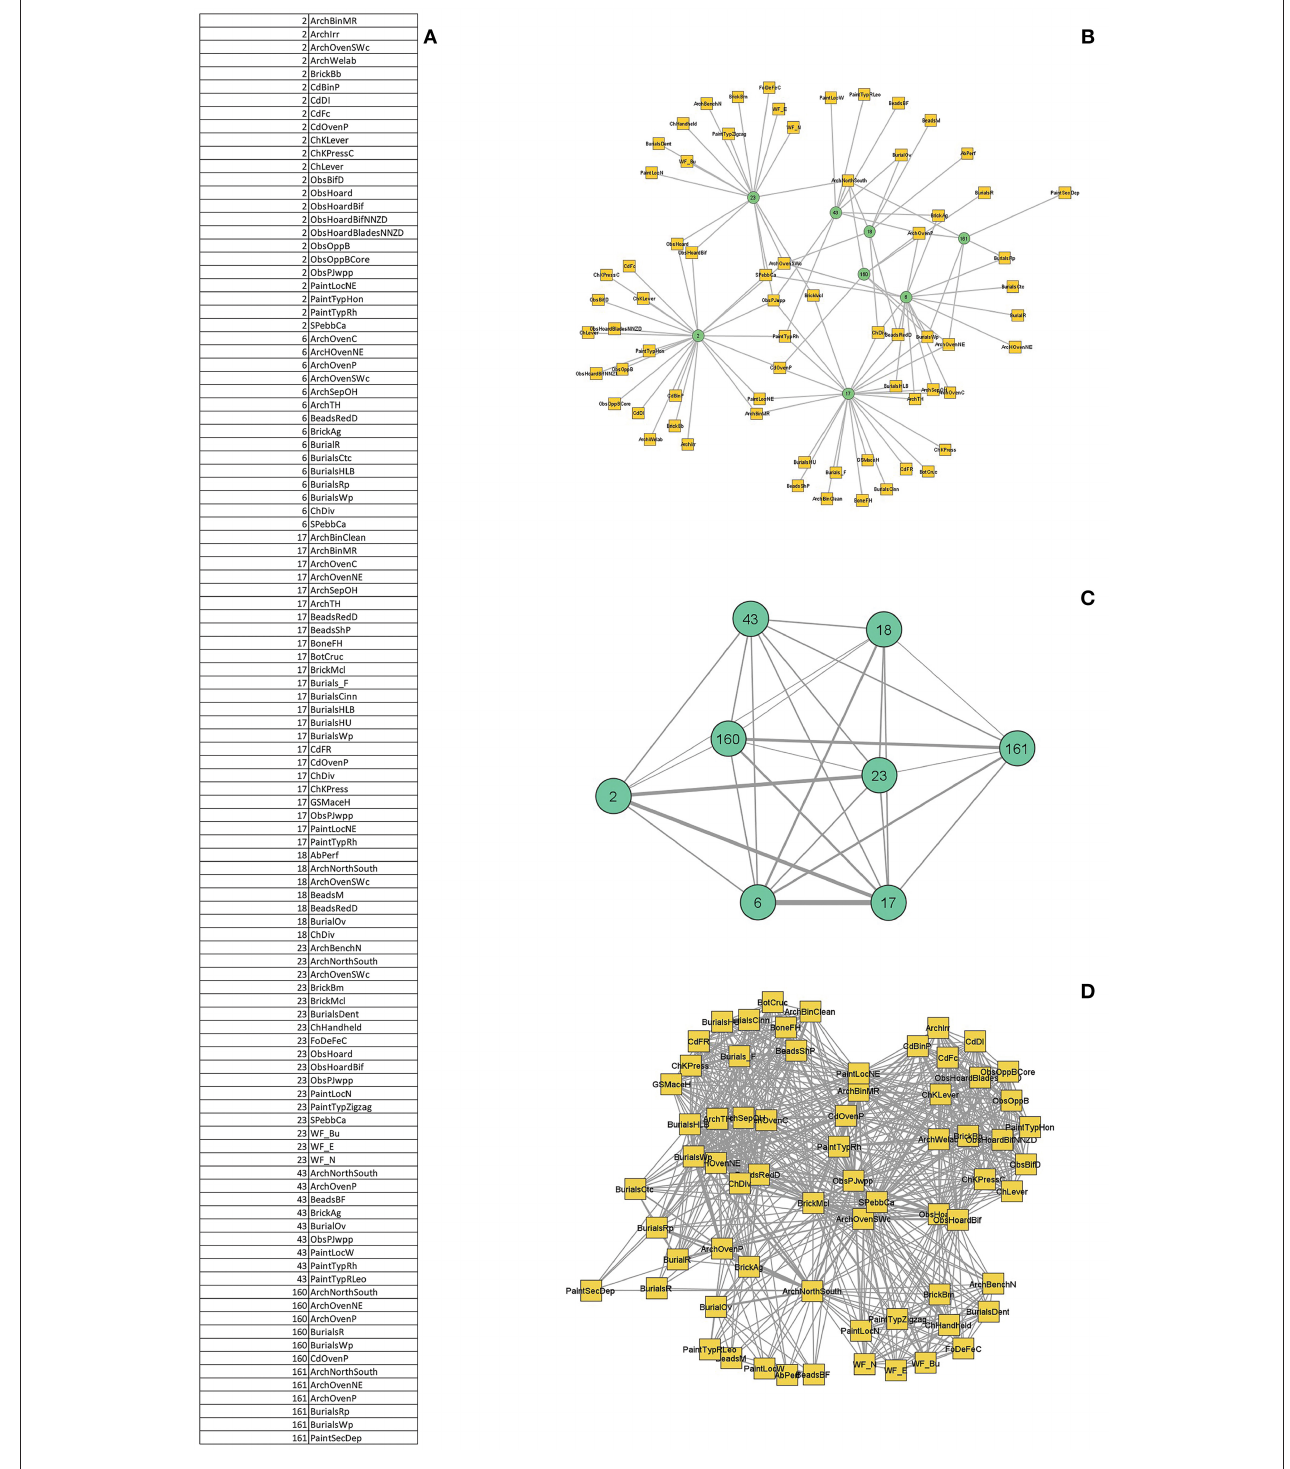
FIGURE 2 | Relevant objects and buildings are recorded and arranged in a nodelist format (UCINET) (A) and displayed as a 2-mode network (B) . 2-mode networks or affiliated networks are made of 2 type of nodes in this case of buildings and objects that are linked (affiliated) to one another. The 2-mode network can be converted in weighted 1-mode networks of buildings (C) or objects (D) . The weighted 1-mode network of buildings links the building (nodes) that share the same objects. The weight of links represents the amount of object that link each couple of buildings. The 1-mode network of objects on the contrary links the object that are co-present in the same building and the weight of the link correspond to the number of buildings shared by couple of objects.